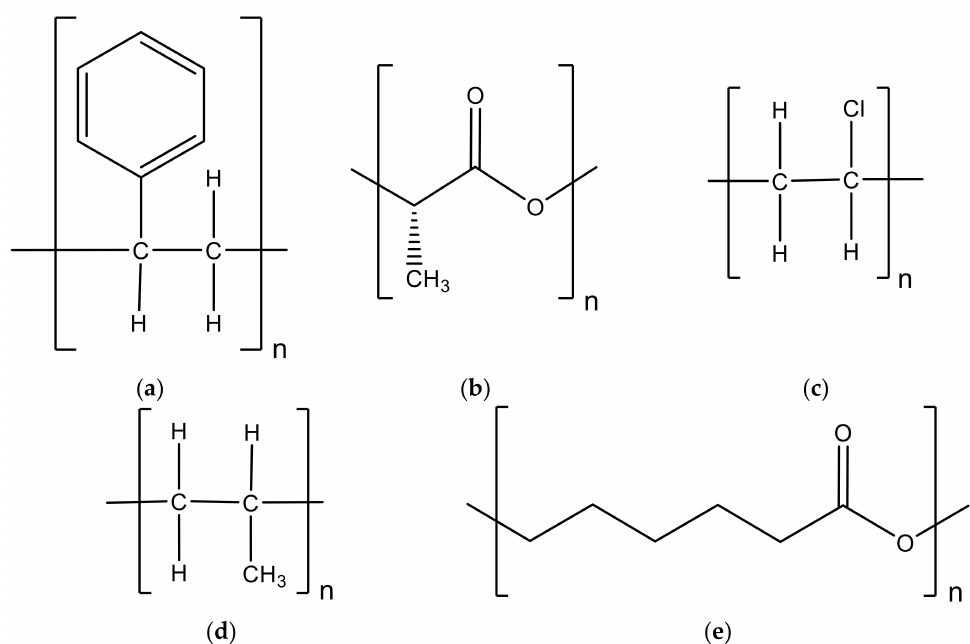
Figure 5. Chemical structures of: ( a ) Polystyrene (PS), ( b ) poly(L-lactide) (PLLA), ( c ) polyvinyl chlo- ride (PVC), ( d ) polypropylene (PP), and ( e ) poly( ε -caprolactone) (PCL) ( n : Number of repeat